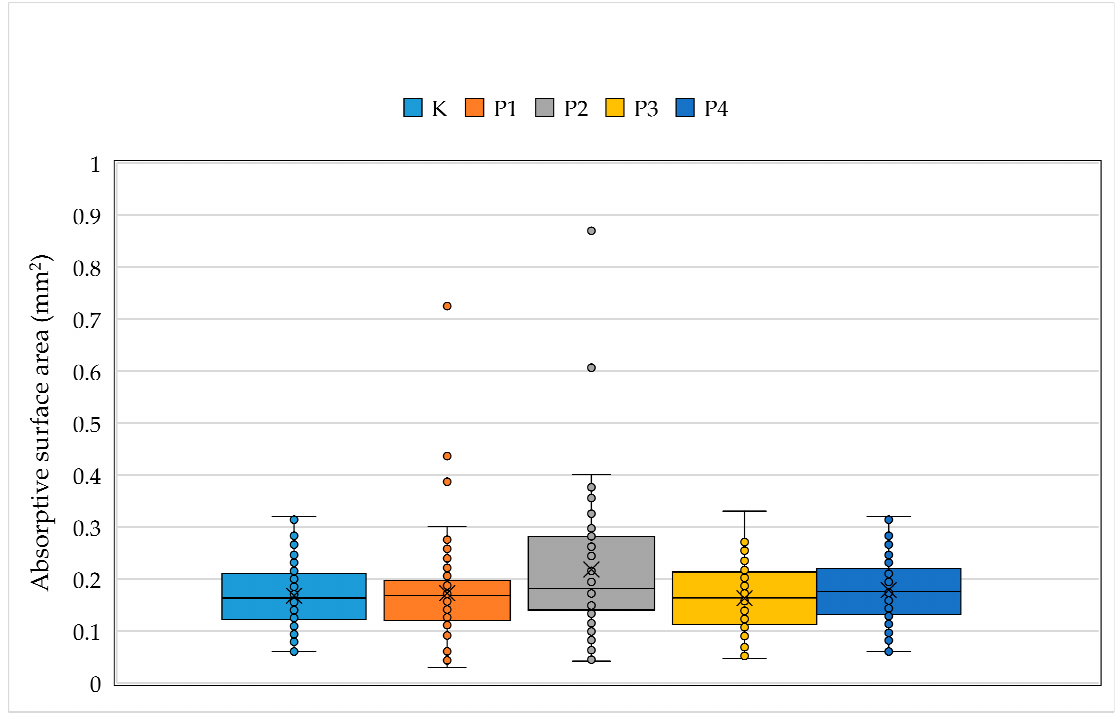
Parameter Table 4. The villus height-to-crypt depth ratio of broiler chickens on the 42nd day of the feeding trial. Parameter